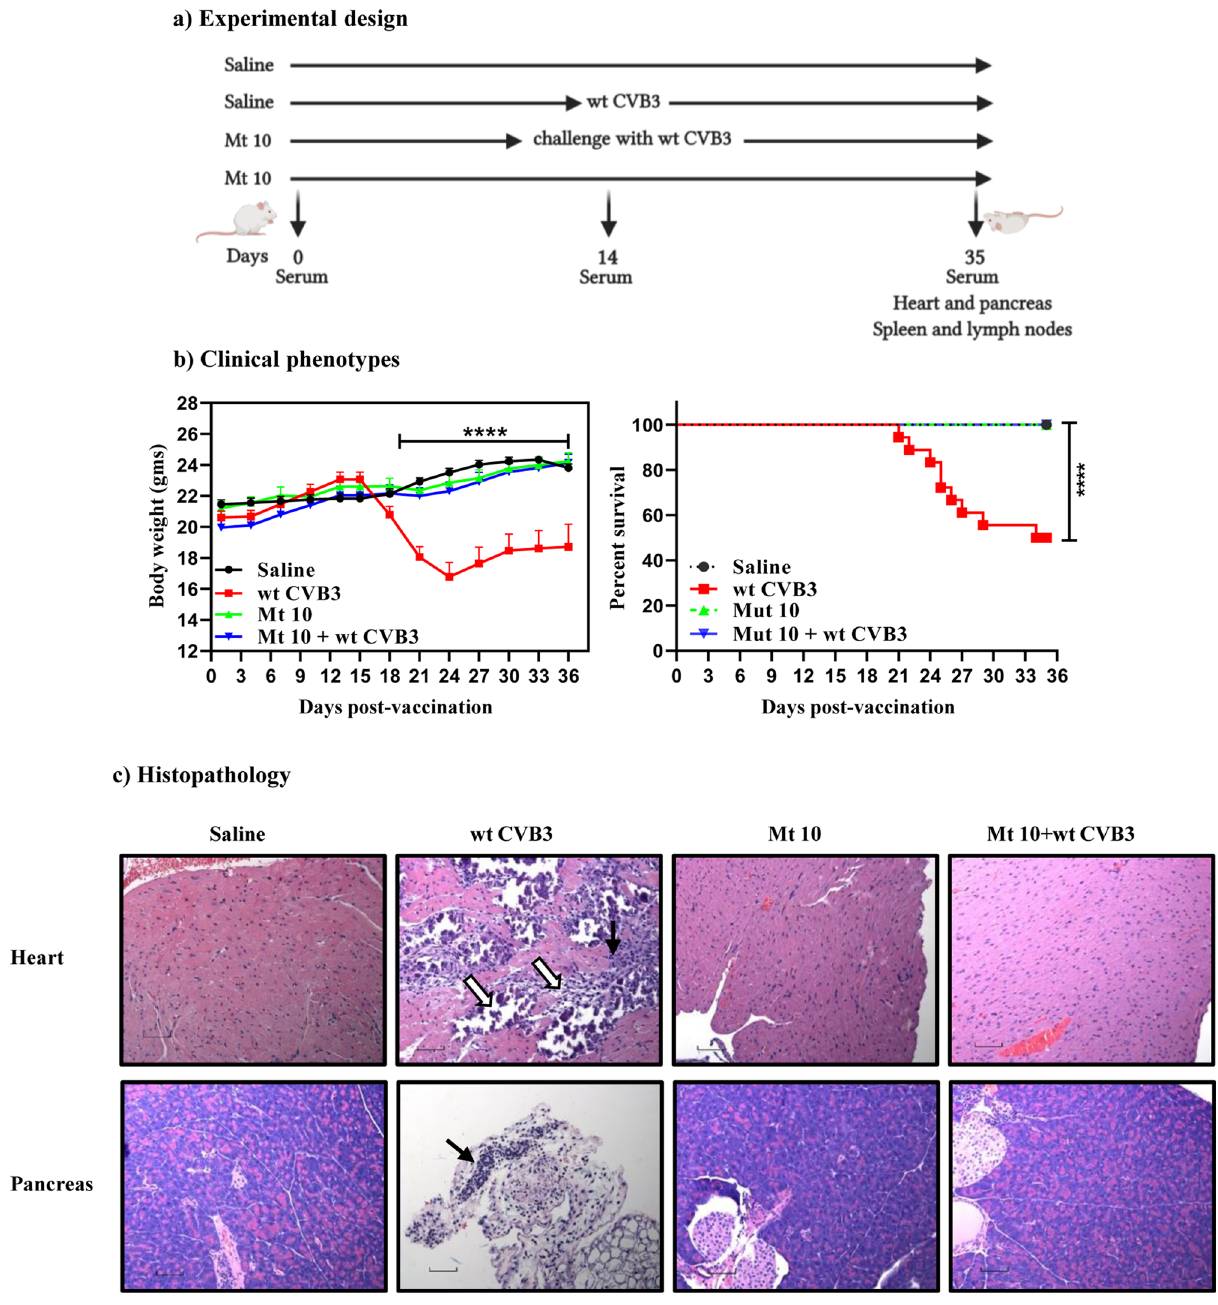
Figure 4. Mt 10 virus offers protection against wt CVB3 infection in challenge studies. ( a ) Experimental design. Two groups of mice each were administered saline or Mt 10 virus on day 0 after serum was collected. After 14 days, serum was collected, and one group from each was challenged with CVB3. Experiments were terminated 21 days later, and serum and tissues were collected for in vitro experimentation. ( b ) Clinical phenotypes. Body weights (left panel) and survival rates (right panel) between different groups are shown. ( c ) Histopathology. Hearts and pancreata collected from the indicated groups and processed by H and E staining to evaluate inflammatory changes. Representative heart (top panel) and pancreatic (bottom panel) sections are shown. Heart sections from wt CVB3 group shows infiltrations (solid arrow) and mineralization, necrosis, and fibrosis (empty arrow). Pancreatic sections from wt CVB3 group had infiltrations (solid arrow) as opposed to normal sections in the saline, Mt 10 virus, and Mt 10 virus/wt CVB3-challenged groups. Magnification, 20×; scale bars, 20 µm. Data sets obtained from three individual experiments, each involving n = 3 to 8 mice, are shown. Two-way ANOVA with a Sidak’s post-test was used to compare body weight changes in vaccine and saline groups relative to wt CVB3 group. Log-rank test with Bonferroni correction was used to compare survival curves. **** p ≤